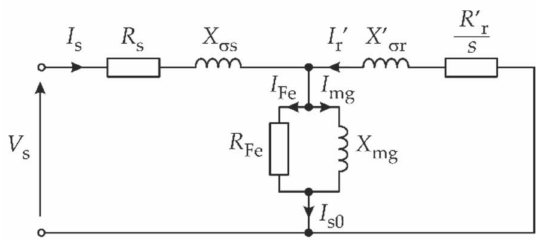
Figure 2. Complete equivalent circuit of the RIM.